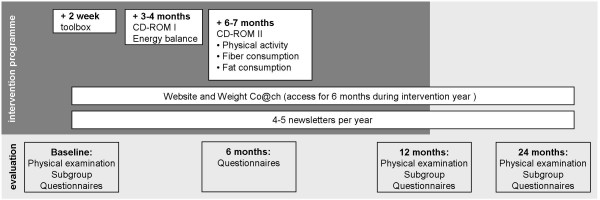
Overview of the intervention programme (dark grey box) and timeline of the evaluation plan (bottom part).